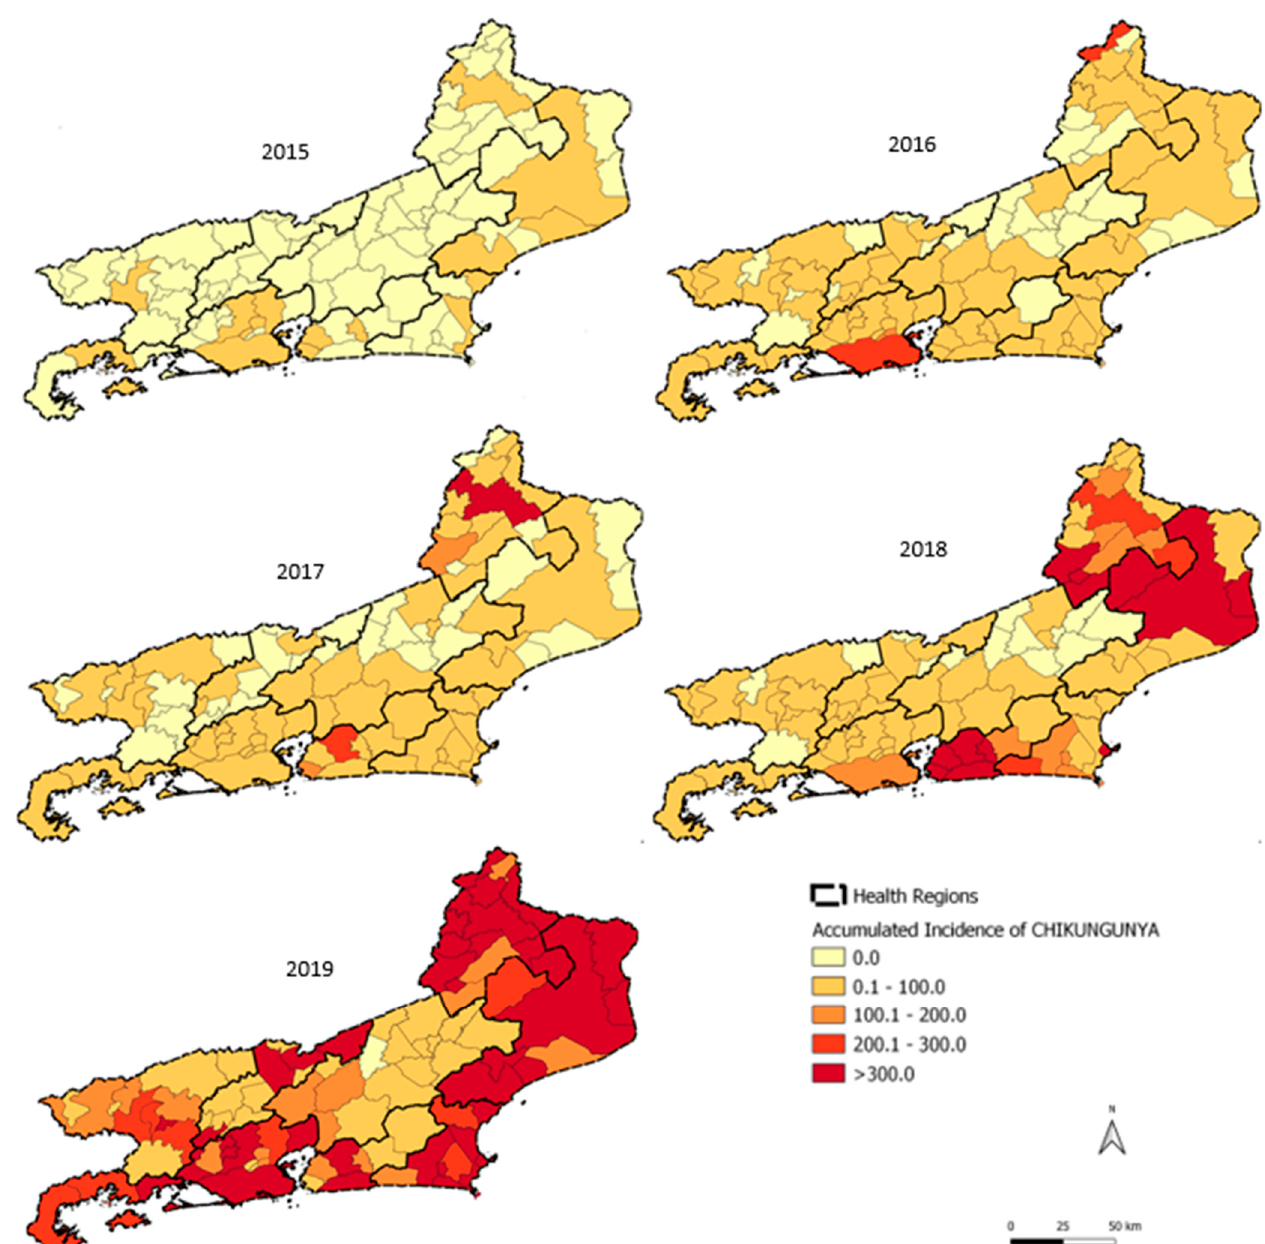
Figure 5. Chikungunya by year of symptom onset in the state of Rio de Janeiro, 2015–2019.